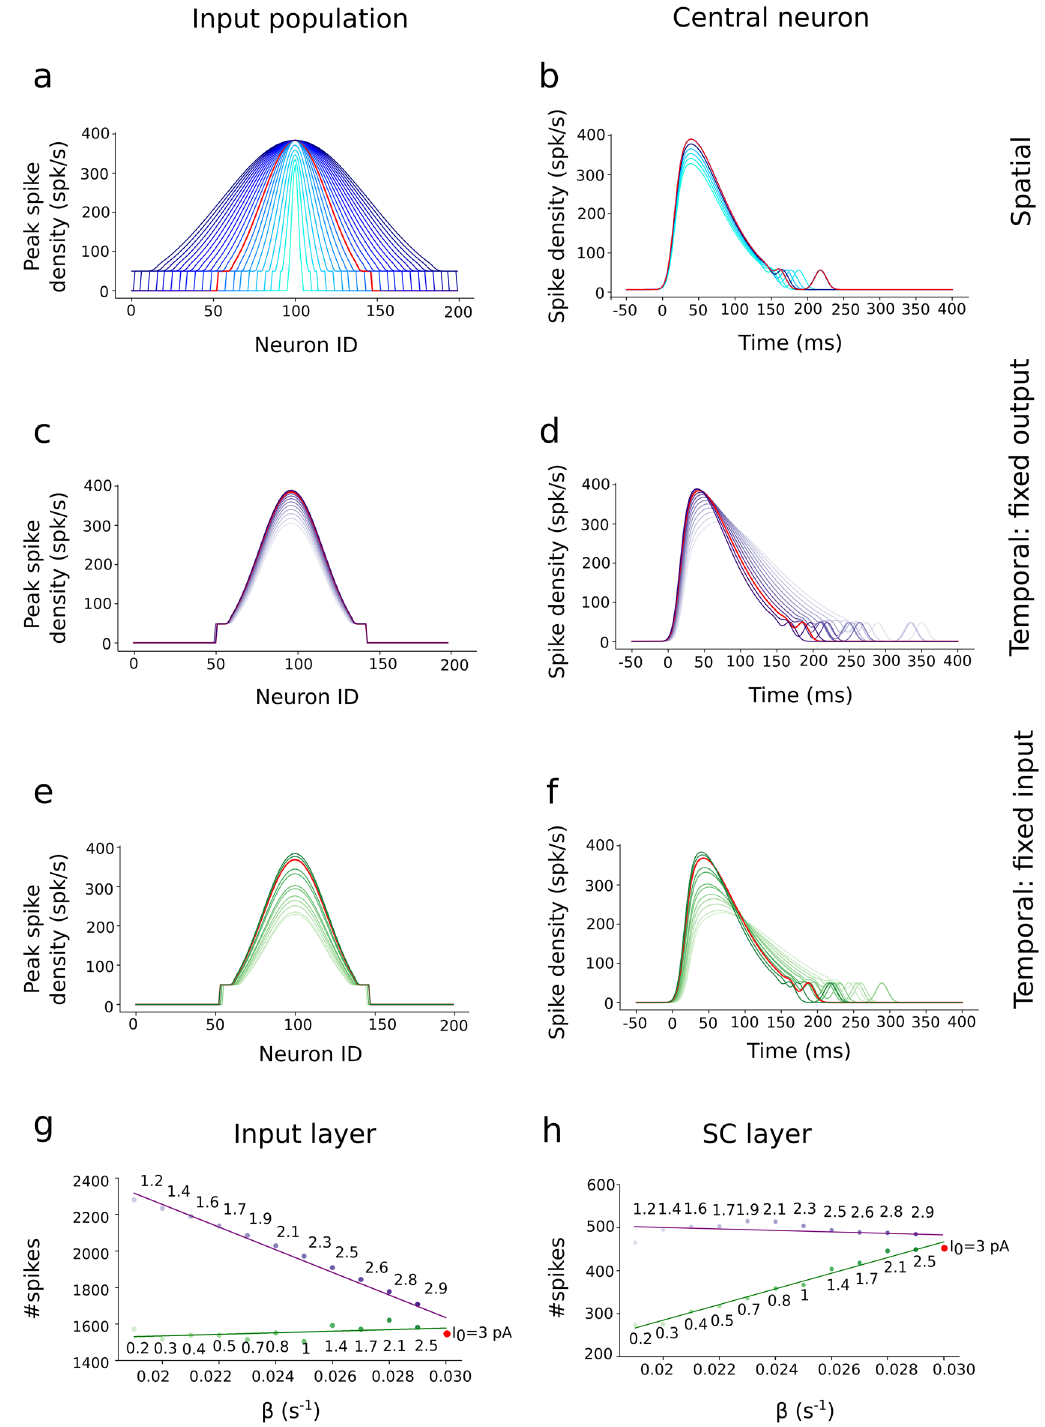
Figure 3. ( a – f ) Burst profiles of the input layer neurons in response to changes in the spatial–temporal parameters of the external input currents (see also S1 Table in Supporting Information). Red curve corresponds to the default parameter set. ( a ) Spatial distribution of the peak spike-density functions for σ pop in 0.05– 1.0 mm, and I 0 in 2.0–3.0 pA at T = 15 deg. ( b ) Spike densities as function of time for the central neuron of the populations in ( a ). ( c , d ) Spatial ( c ) and temporal ( d ) spike-density distributions for β in 0.019–0.03 s −1 , and I 0 in 1.2–3.0 pA at the T = 15 deg site (σ pop = 0.5 mm ) . Parameter values of the input currents were chosen such that the SC output generated a fixed number of spikes. ( e , f ) Spatial ( e ) and temporal ( f ) spike-density distributions for β in 0.019–0.03 s −1 and I 0 in 0.2–3.0 pA. Parameters now ensured a fixed number of spikes in the input layer. ( g ) Total number of spikes in the input layer for the two temporal variation scenarios (green and purple data). ( h ) Same as in ( g ) for the output